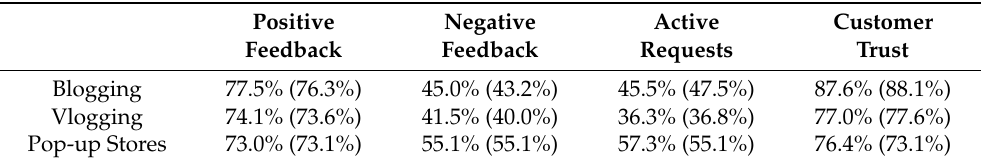
Table 4. Customer participation (at least once) by type of new professional service. Numbers in brackets refer to the 18–34 years of age customer group.